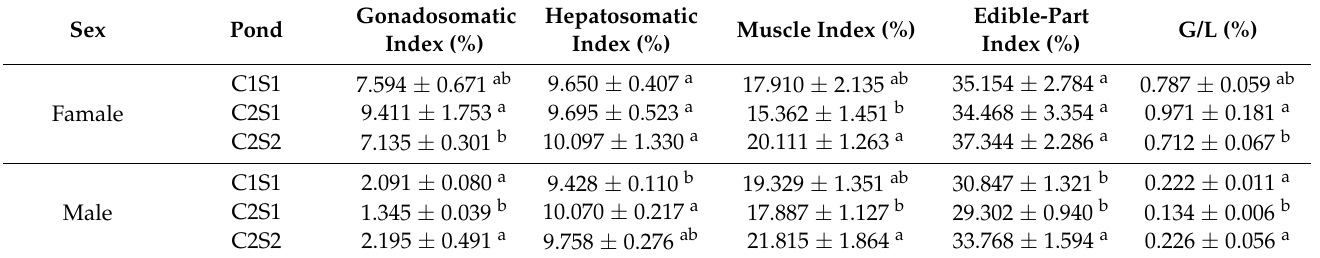
Table 2. Comparison of edible-part index of E. sinensis during maturation period in different ponds.